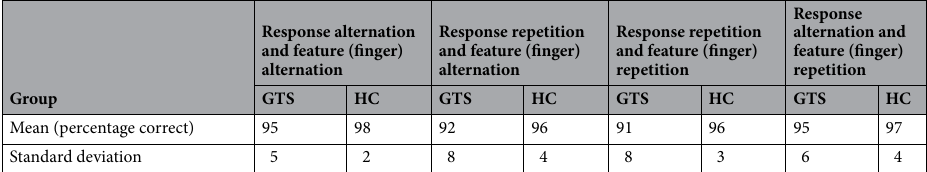
Table 2. Descriptive statistics (accuracy rates). Mean accuracy rates (percentage correct) for each group and condition including respective standard deviations.